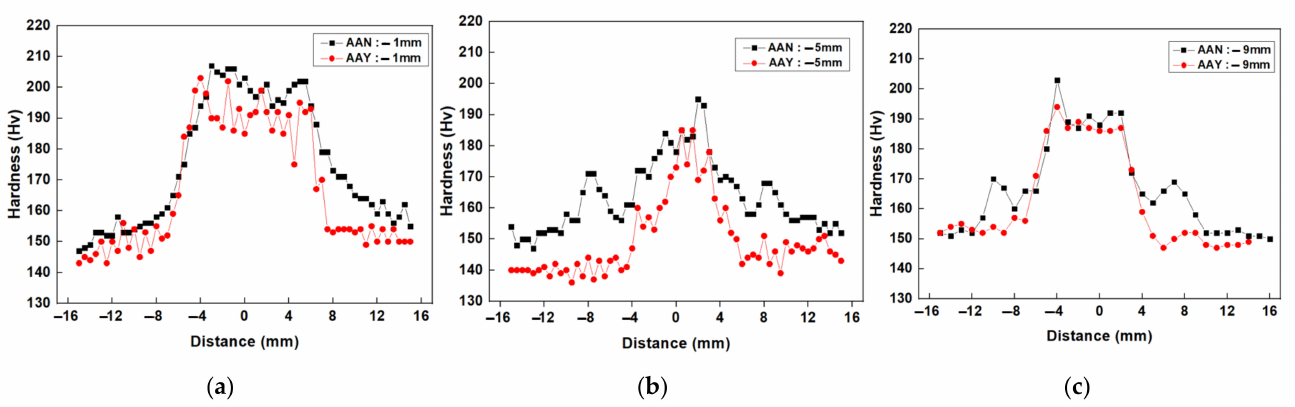
Figure 16. Microstructures ( × 200). ( a ) Parent material, non PWHT; ( b ) HAZ, non PWHT; ( c ) parent material, PWHT at 590 ◦ C; ( d ) HAZ, PWHT at 590 ◦ C.